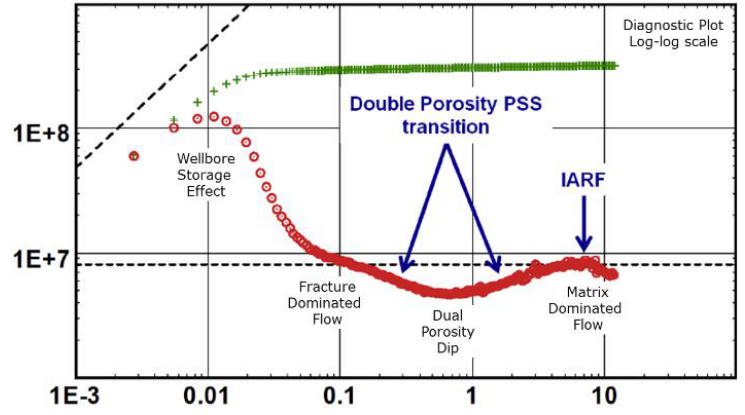
Figure 7—Signature of a dual porosity reservoir on a diagnostic plot.